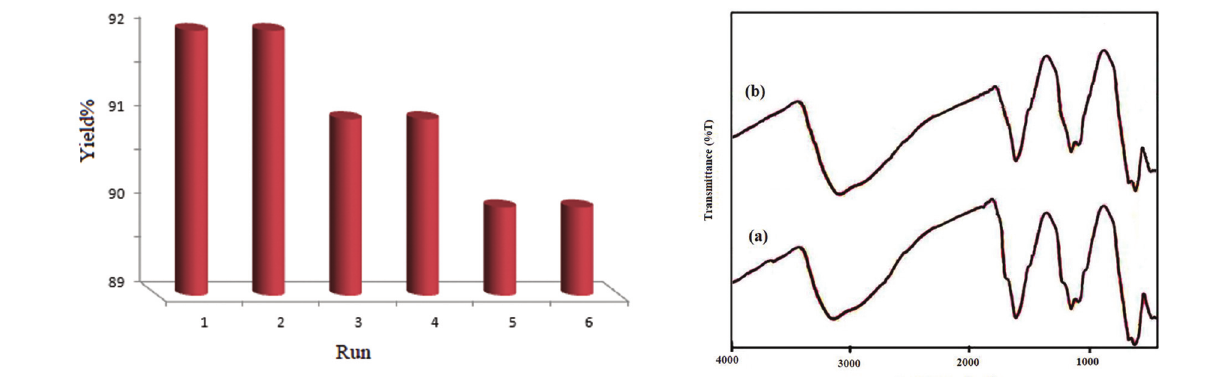
Figure 8: Reusability of Fe catalyst for the synthesis of 4c . Figure 9: FT-IR analysis before and after reuse of the Fe